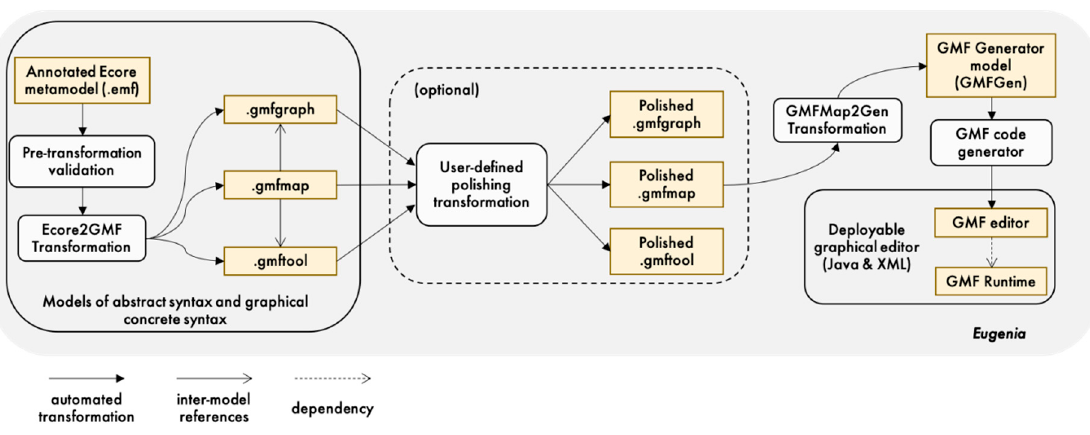
Figure 2. Outline of the Eugenia development